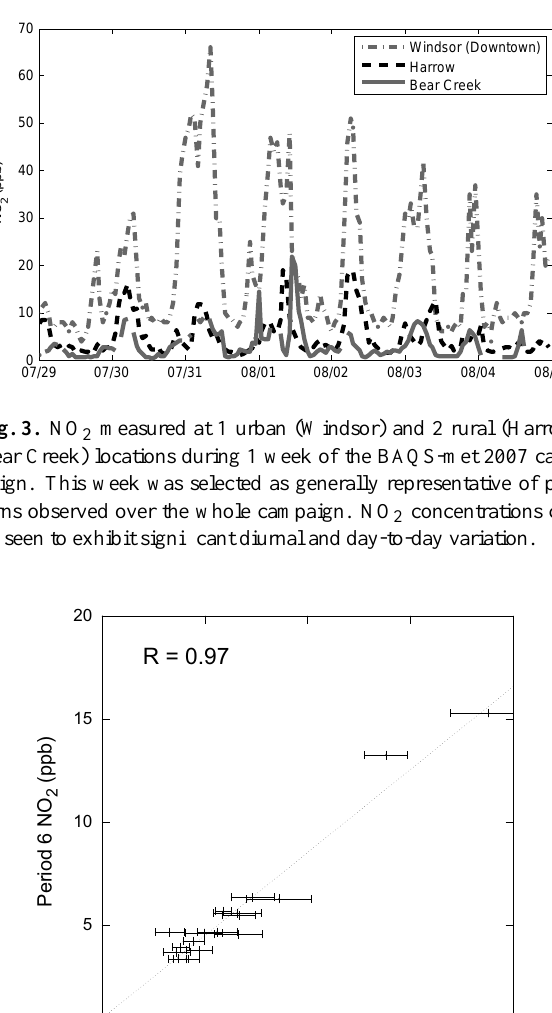
Fig. 4. Single sampling period average NO 2 concentration vs. same-site campaign average concentrations for sampling period 6 (7–21 August). Error bars show ± 1 standard deviation from same- site averages. This sampling period represented the lowest linear correlation against the average concentration.